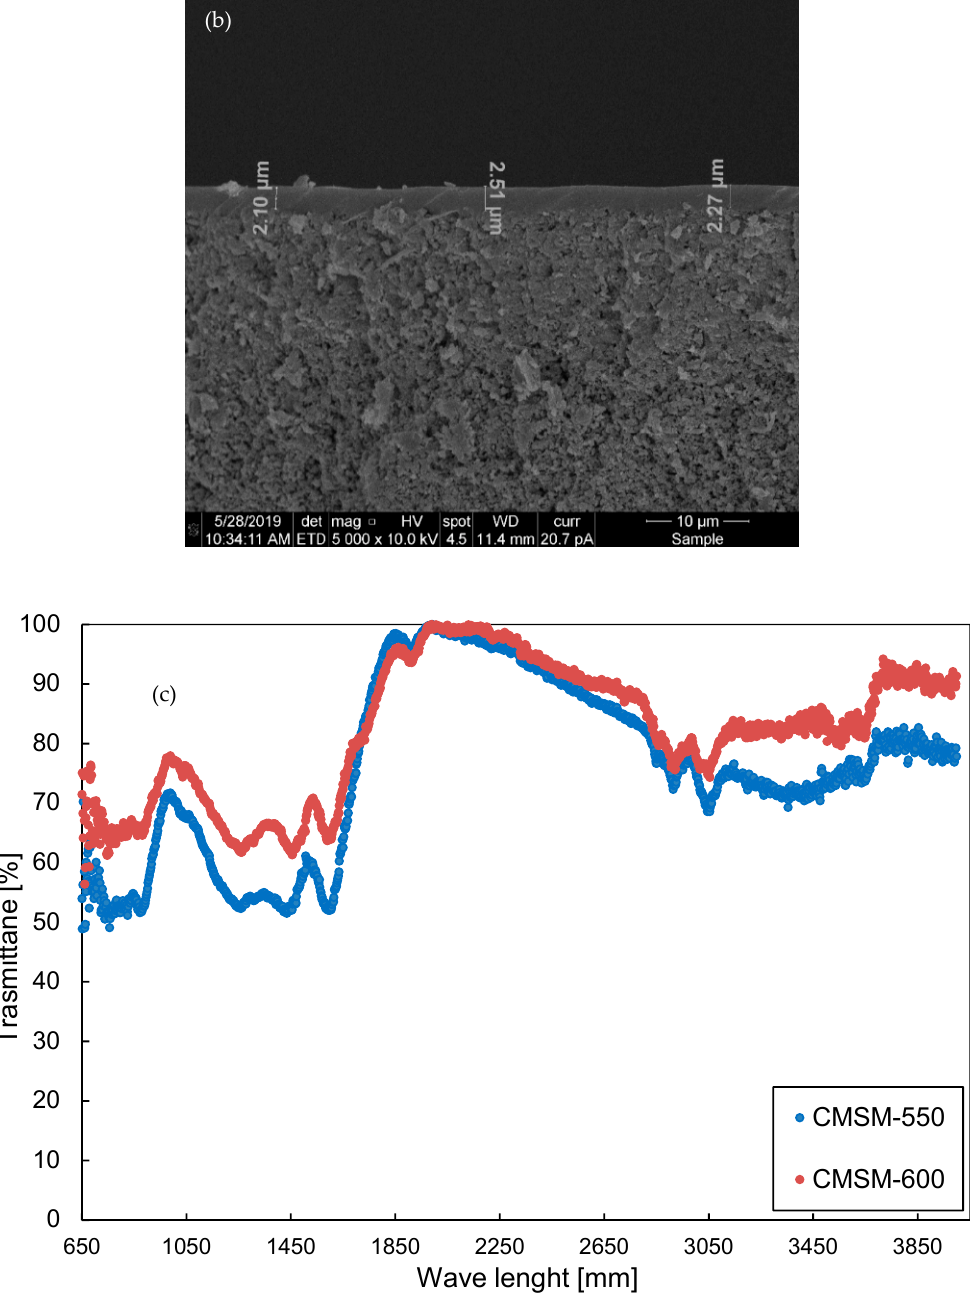
Figure 3. Scanning electron microscopy of CMSM-550: ( a ) top section of the membrane ( b ) bottom section of the membrane. ( c ) Fourier transform infrared (FTIR) of CMSM-550 and CMSM-600.